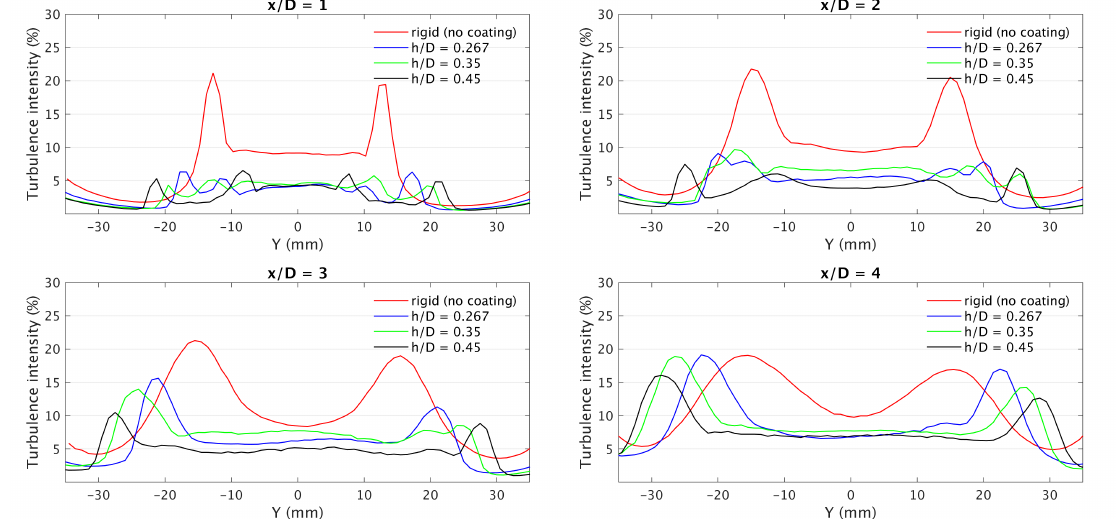
Figure 14. Turbulence intensity graph for cylinders 1, 5, 9, and 10.